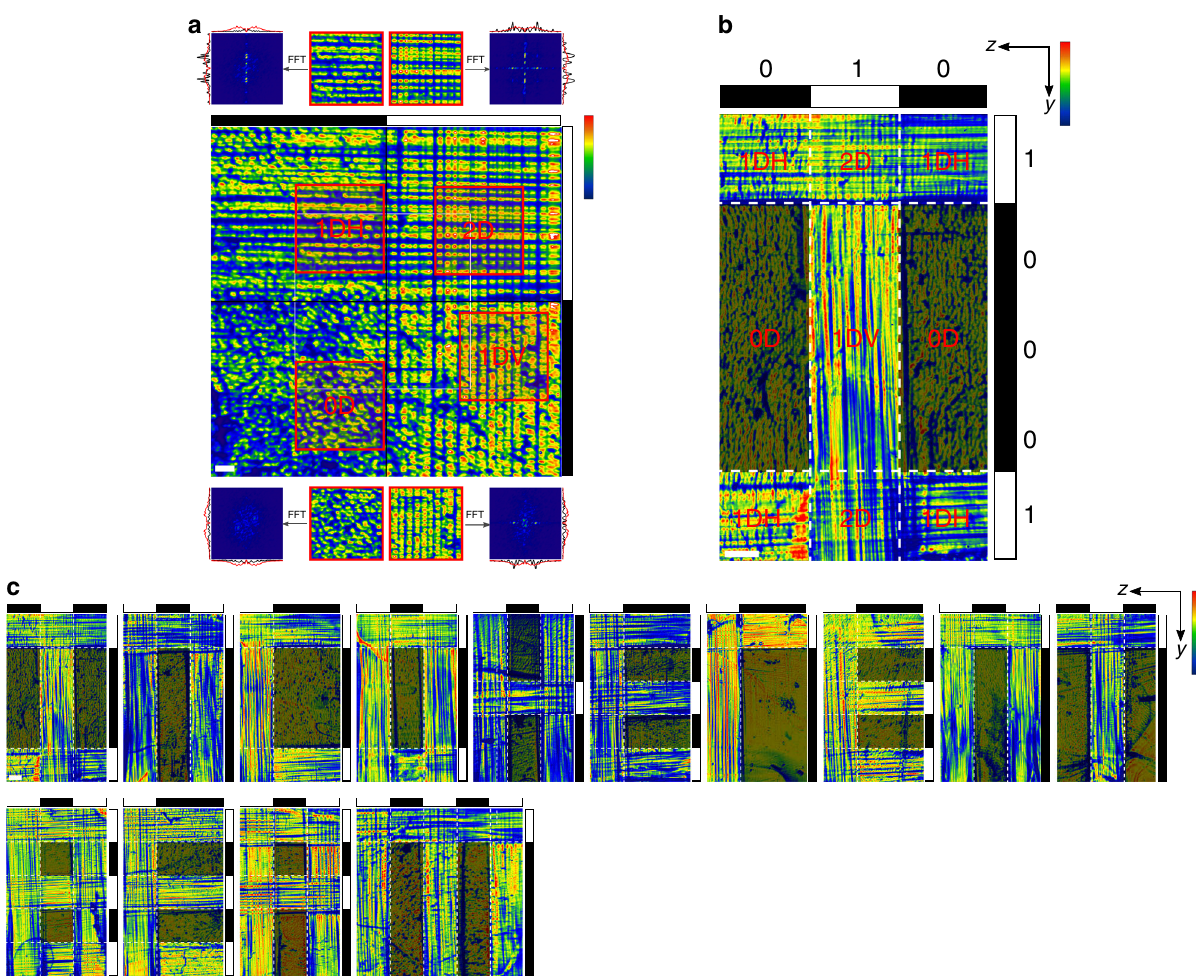
Fig. 3 Single-step volumetric encoding in the photopolymer cuboid. Output face ( yz plane) of polymer cuboid when a encoded by two identical binary strings 0 (black bar) 1 (white bar) introduced along the y and z axes. The four carrier con fi gurations at the output were quanti fi ed through Fast Fourier Transform (FFT) analysis of select regions indicated by red squares; b when encoded by binary strings 010 and 10001 to generate the letter “ I ” . Carrier con fi gurations are labeled; c when encoded with different binary string pairs to generate words “ incoherent beam ” . ( a – c blue (minimum) to red (maximum) intensity scales are provided; scale bar = 500 μ m; b – c the 0D con fi guration has been dulled to guide the